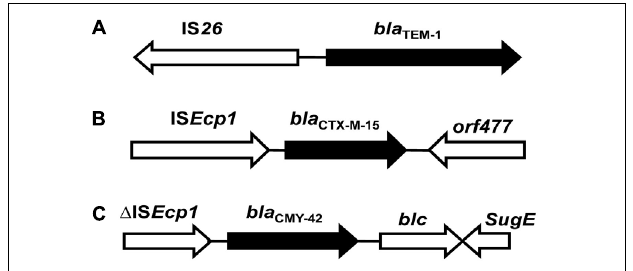
FIGURE 1 | Schematic representation of genetic environment of bla TEM - 1 , bla CTX - M - 15 , and bla cmy - 42 genes. The arrows indicate bla genes and upstream and downstream sequences detected by PCR. The direction of the arrows indicates the orientation of gene transcription. (A – C) Represents genetic environment of bla TEM - 1 , bla CTX - M - 15 , and bla cmy - 42 ,